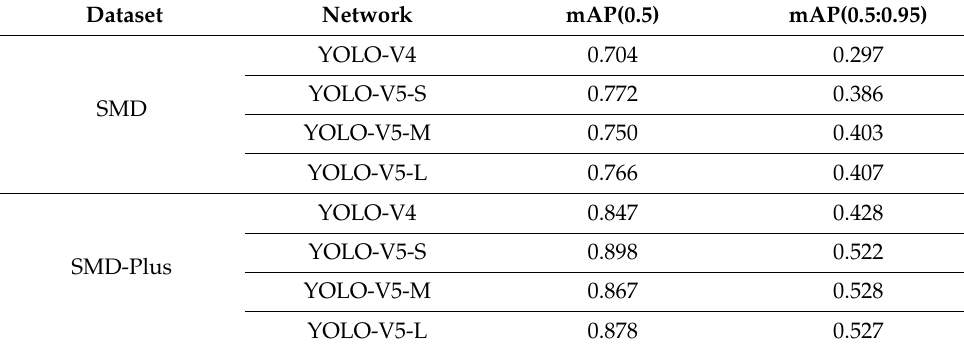
Table 4. Comparison of foreground and background detection of the SMD and the SMD-Plus. mAP(0.5) represents the mean average precision (mAP) for IoU = 0.5, while mAP(0.5:0.95) is the averaged mAP for increasing IoU threshold values, from 0.5 to 0.95 by 0.05. Dataset Network mAP(0.5) mAP(0.5:0.95)